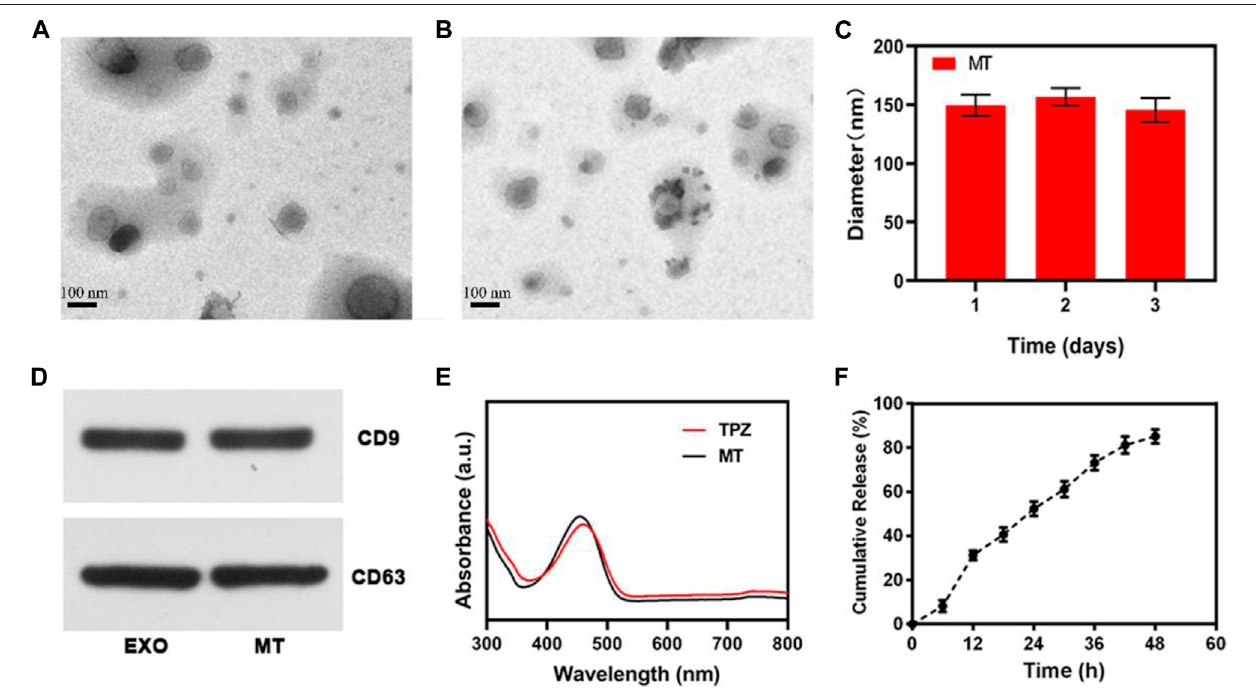
FIGURE 1 | (A) TEM images of EXO preparations. (B) TEM images of MT preparations. (C) DLS was used to measure the hemodynamic diameter of MT nanovesicles. (D) EXO marker proteins CD9 and CD63 were assessed via Western blotting. (E) UV-vis spectra for TPZ and MT nano-vesicles in PBS (F) In vitro TPZ release from MT over time at 37 ° C. Scale bar: 100